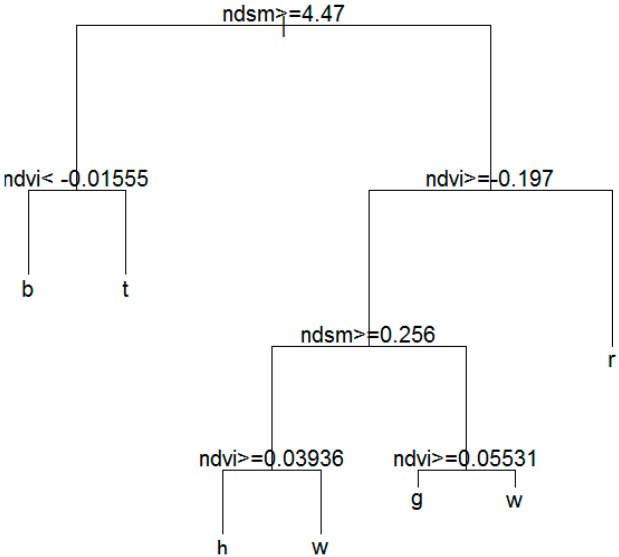
Figure 12. Decision tree derived from training areas (b = “building”, t = “tree”, g = “grass”, h = “hedge and bush”, r = “road and parking lot”, w = “wall and car port”; ndvi = normalized difference vegetation index; ndsm = normalized digital surface model). Taken from [12].